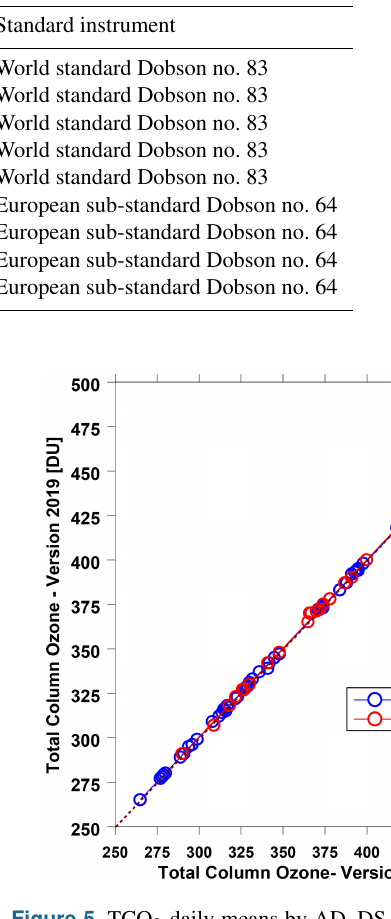
Figure 5. TCO 3 daily means by AD–DS measurements in the pe- riods 1963–1964 and 1980–1981 calculated with the present (2019) calculation algorithm (R–N tables based on the 2014 intercompari- son) vs. those by the same algorithm using old (1979) R–N